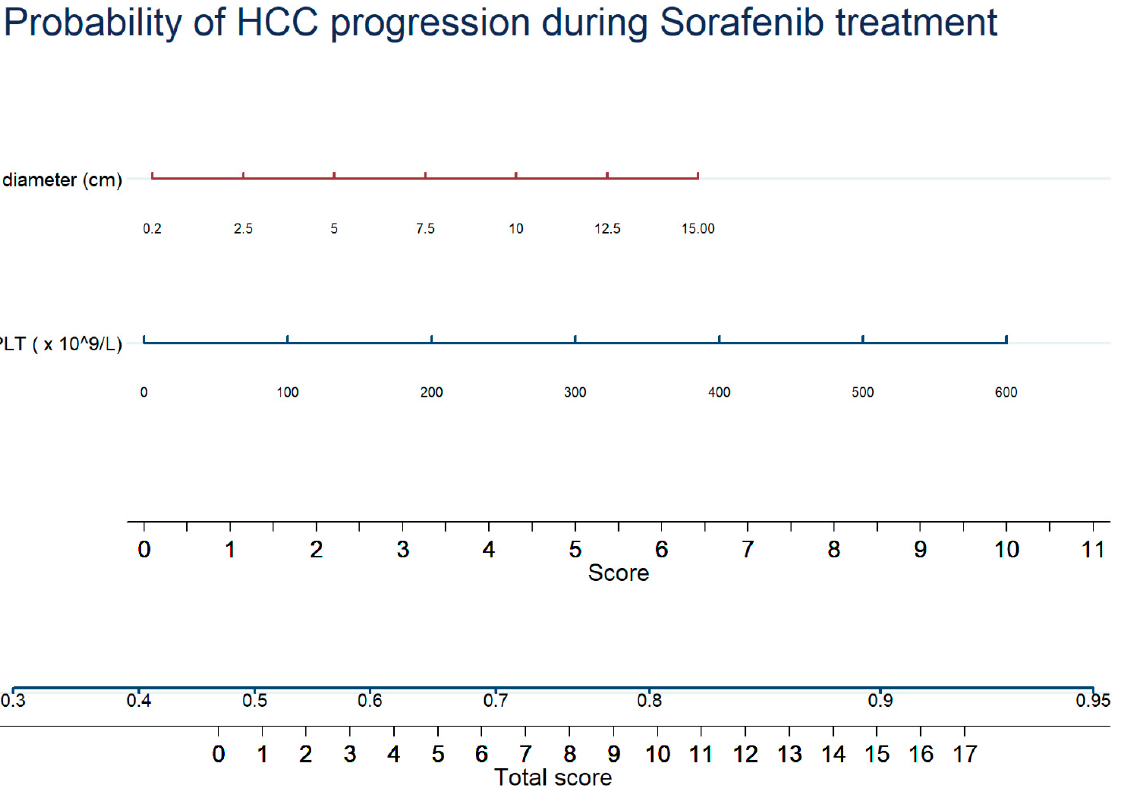
Figure 3. Nomogram for the prediction of radiological progression according to mRECIST criteria for patients with advanced HCC starting Sorafenib treatment. The effect of each variable on the prediction of HCC radiological progression is obtained drawing a vertical line from variable’s line up to the “Score” line. The total score is obtained by adding the score for each variable. The probability of HCC radiological progression is obtained drawing a vertical line from “Total score” up to the Prob. (probability) line.